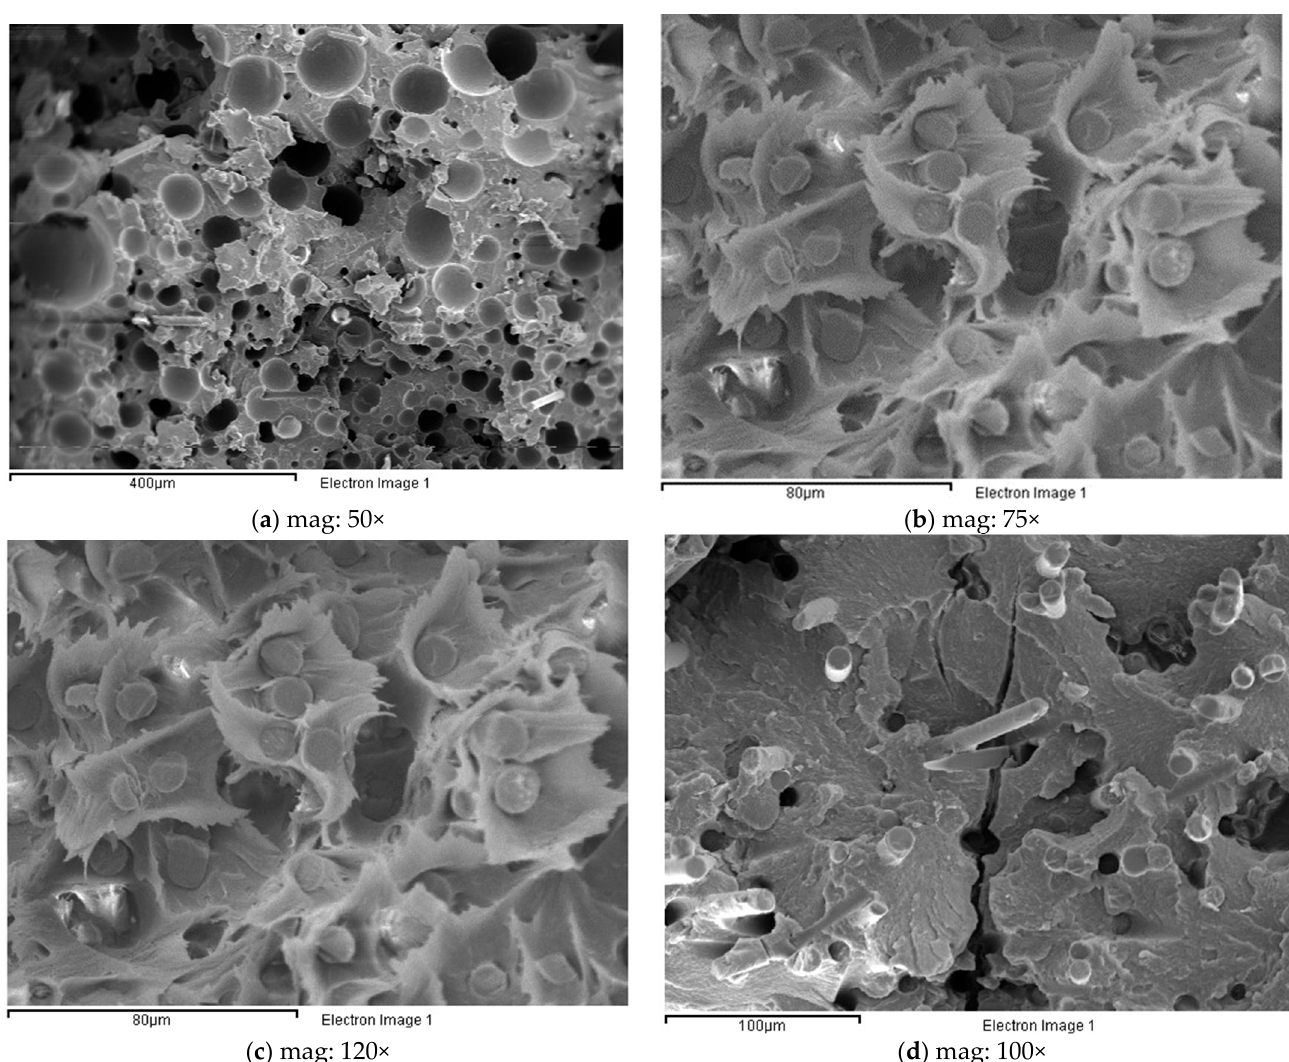
Figure 10. SEM fractographic analysis. ( a ) Fatigue failure surface of specimens R10. ( b ) Fatigue failure surface of specimens R9. ( c ) Low recycling number (R1) failure surface. ( d ) Crack growth mechanism for specimen R4.